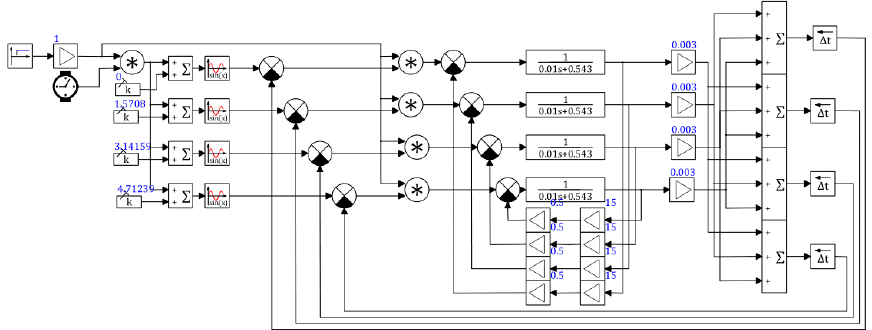
Figure 18. Mathematical model of a two-phase generator.